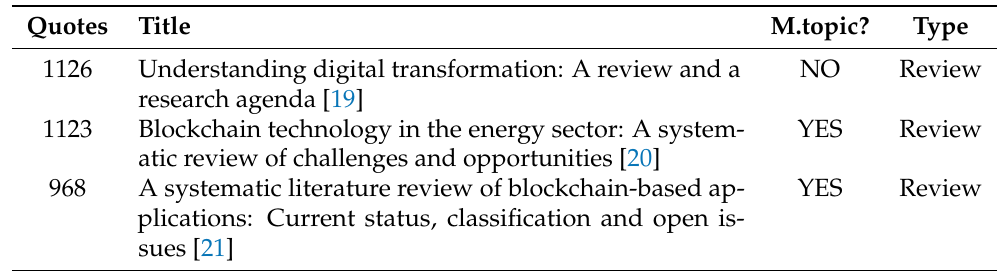
Table 6. Top 3 citations